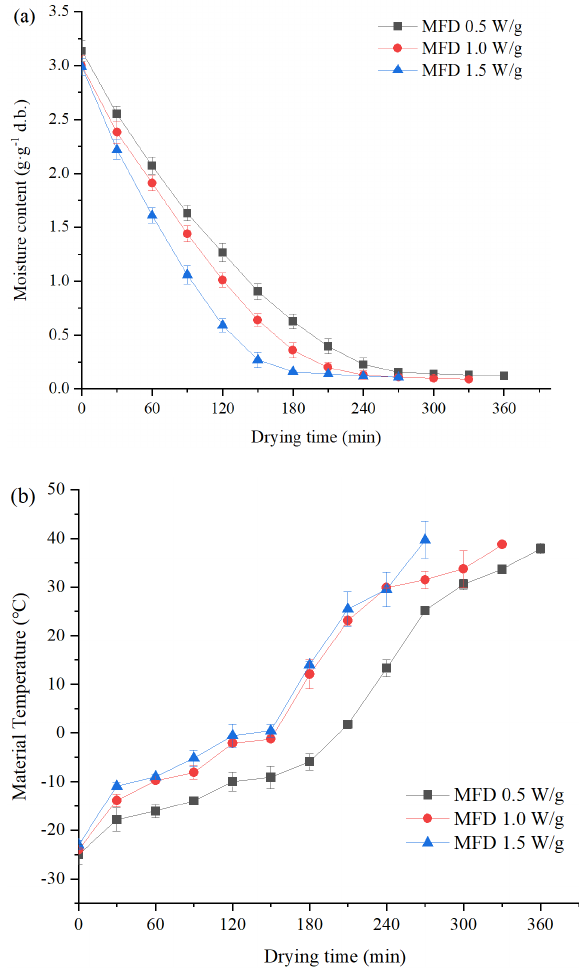
Figure 1. Drying characteristics of MFD for yams under different microwave power densities: ( a ) drying curves and ( b ) temperature profile.